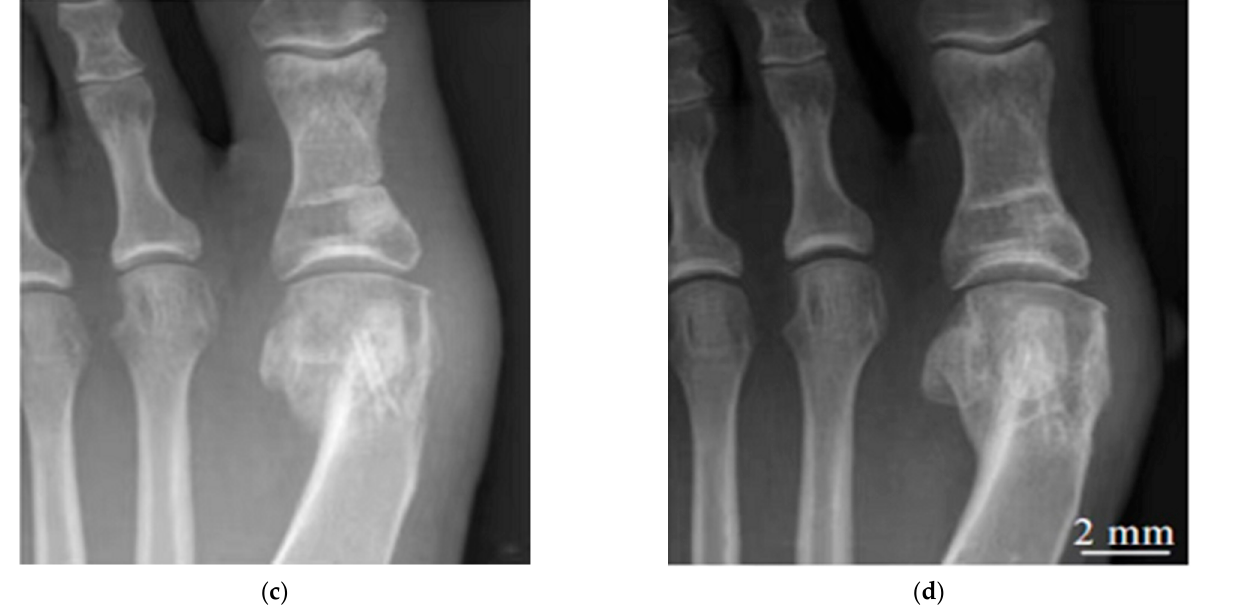
Figure 13. Before operation ( a ), 6 weeks after operation ( b ), 12 weeks after operation ( c ), and 16 months after operation ( d ) [66]. Table 4. Clinical trials with magnesium alloys.